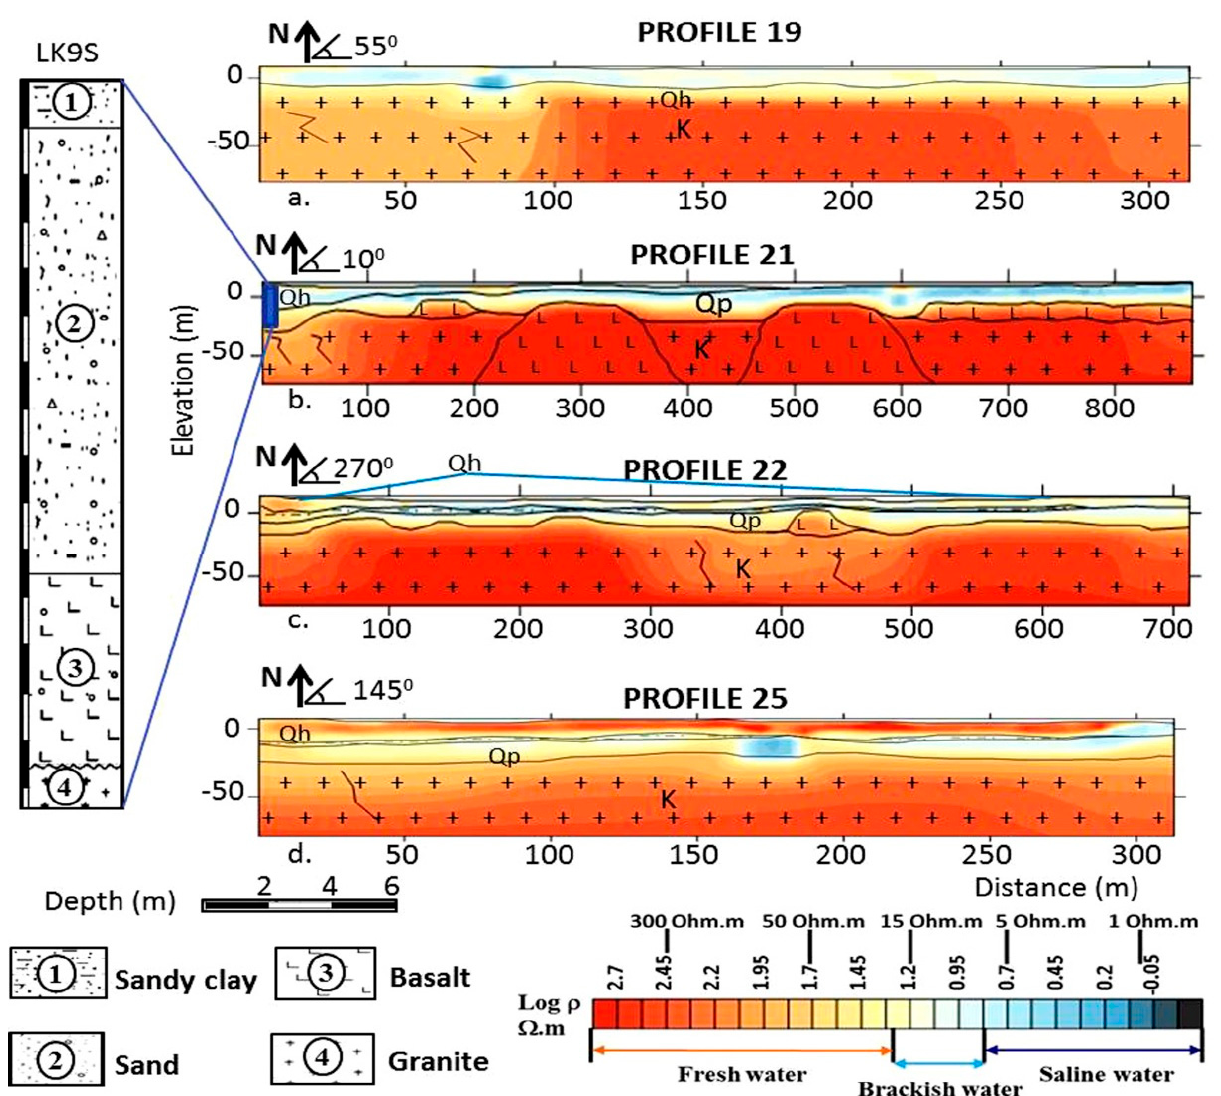
Figure 7. Resistivity distribution of representative profiles and correlation with lithological description in the upstream part. The variation in color indicates resistive characteristics. Blue corresponds to saline water. Freshwater is present in light yellowish-brown areas and brackish water in intermediate colors. Qh, Qp: Holocene and Pleistocene aquifers; K: Deo Ca Cretaceous granite complex.